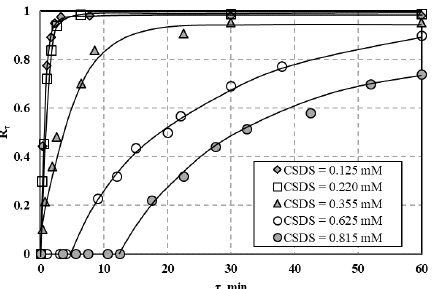
Figure A13. Changes in Al(III) temporary removal ratio during precipitate flotation from solution containing Al(III), Cu(II), and Zn(II) mixture—effect of collector concentration (c 0 = 0.15 mmol dm − 3 , pH = 8.0, u G = 1.51 mm s − 1 ).